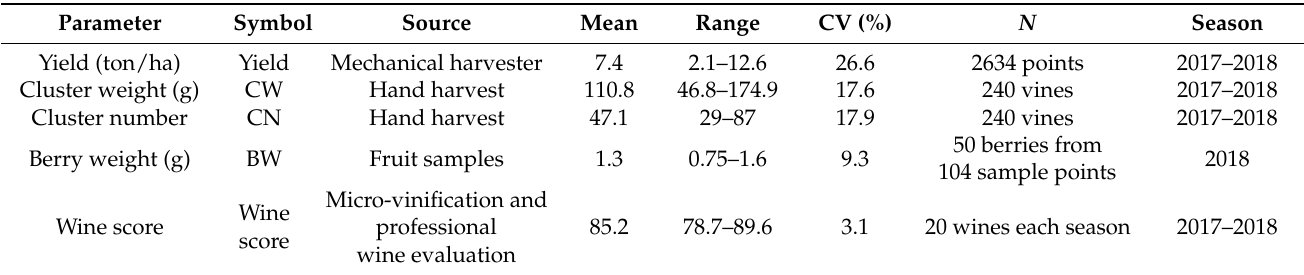
Table 4. Descriptive statistics of yield and wine variables. CV stands for the coefficient of variation